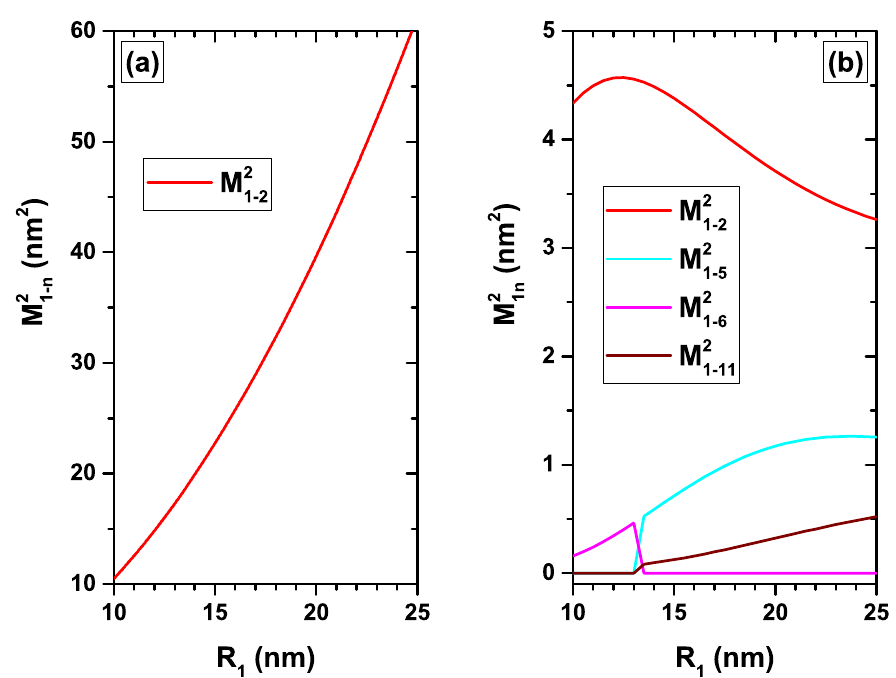
Figure 6. (color online) The squared matrix elements for transitions from the ground state to the first fourteen excited states with l = 0 ( | 1 (cid:105) → | n (cid:105) , with n = 2,3, . . . ,15) of a confined electron in a CdS/ZnS spherical QD as functions of the R 1 -inner radius. Results are without ( a ) and with ( b ) on-center donor impurity, with R 2 = 30nm, and without EF and MF